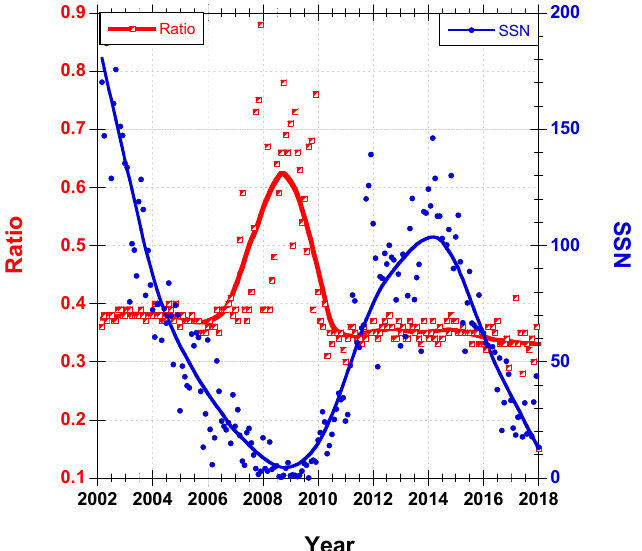
Figure 3. A comparison between the monthly mean values of the ratio index of the solar flares time profiles and the monthly mean sunspot numbers during the period of study 2002–2018.